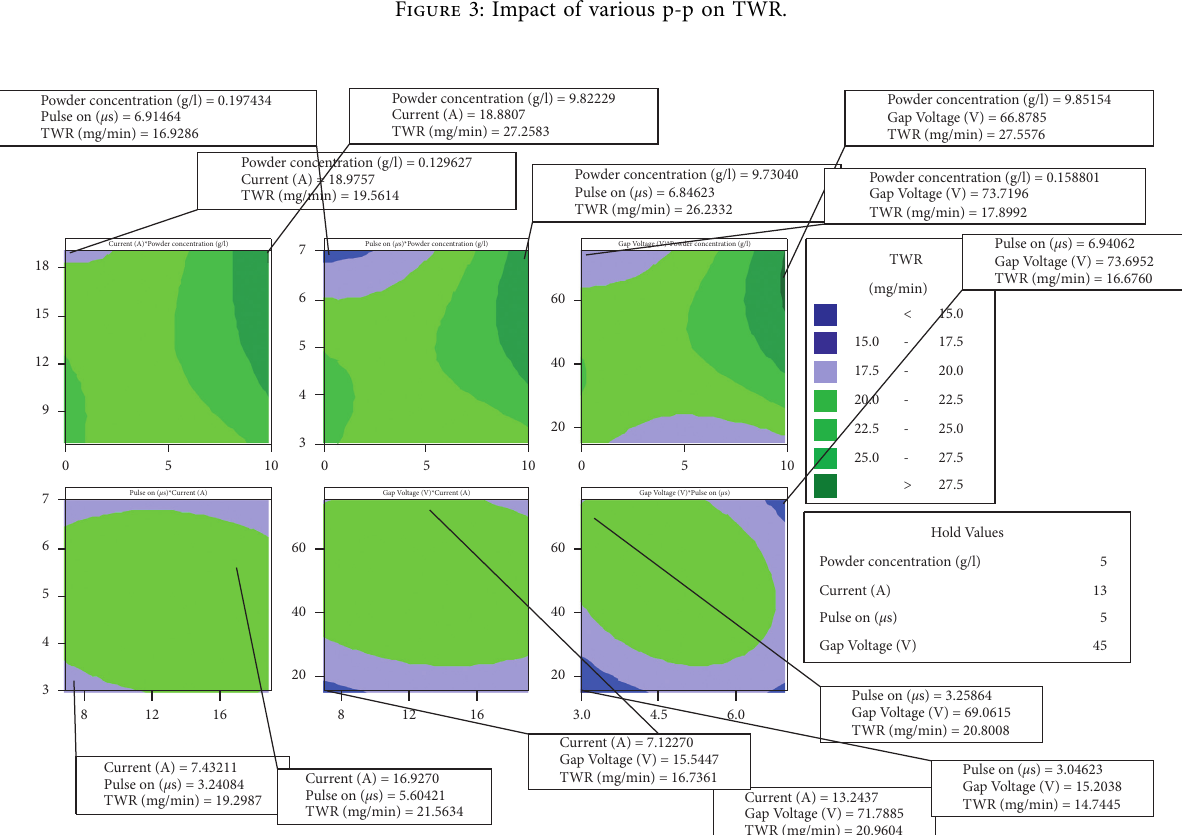
Figure 4: Interaction plot impact of distinct input variables vs. TWR of AA2024/5Al